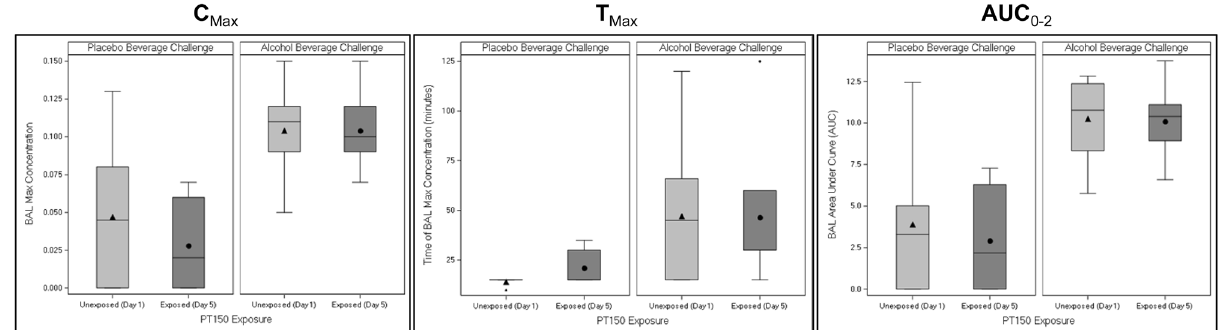
Figure 5. Pharmacokinetic effects of PT150 in combination with ethanol on blood alcohol levels as estimated from breathalyzer; the box represents the interquartile range (IQR, 25th percentile to 75th percentile). Within the box, the horizontal line is the median and the symbol (triangle for day 1 and circle) is the mean. Whiskers represent the min/max, with the exception of outliers which fall outside the IQR by a distance greater than 1.5 times the IQR distance.